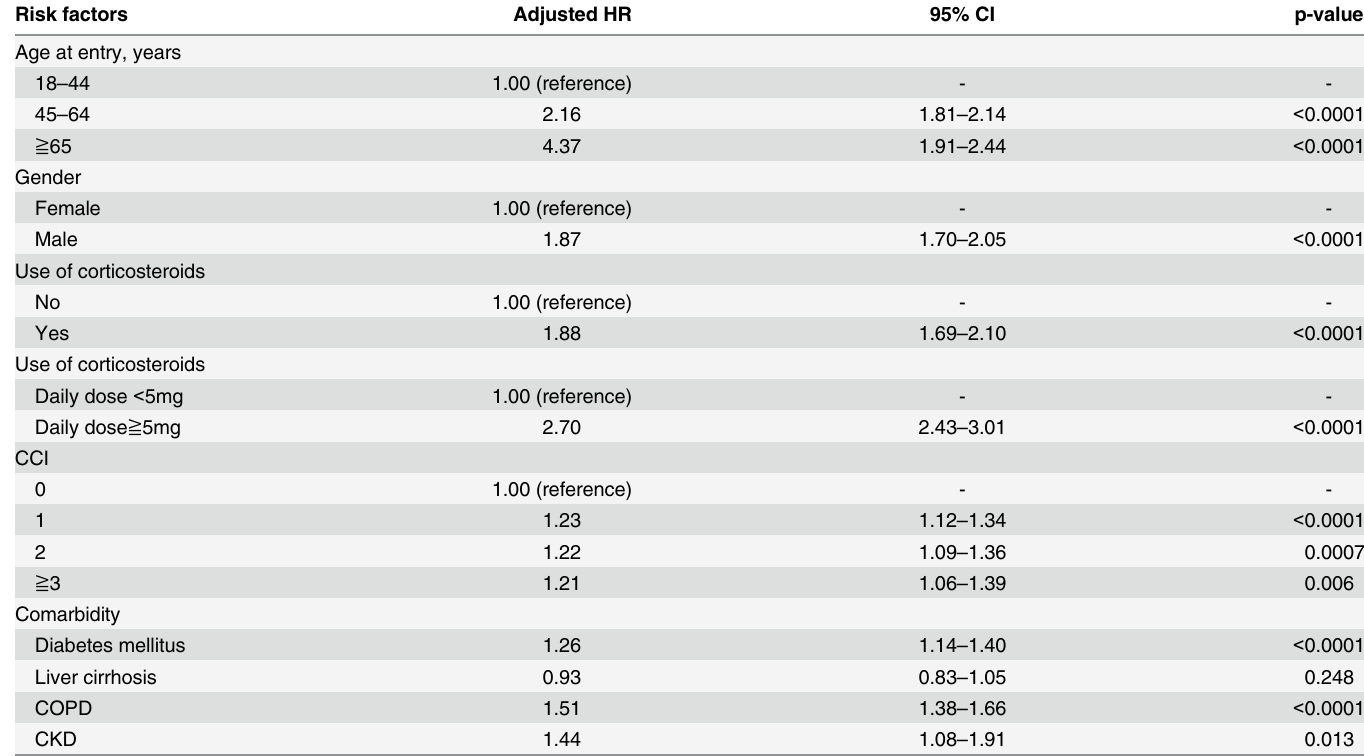
Table 2. Risk factors for developing TB adjusted by age at entry, sex, the use of corticosteroids, comorbidities and Charlson comorbidity index (CCI) in rheumatoid arthritis